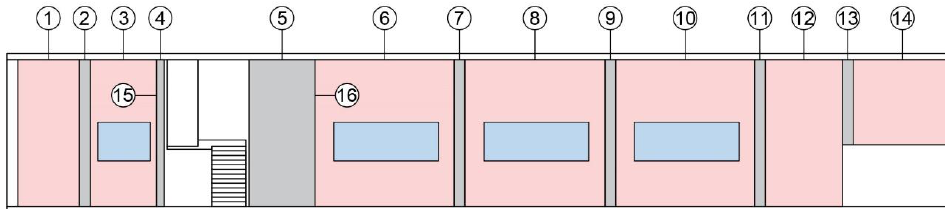
Figure 4. North wall surfaces identification within the CFD validated model.